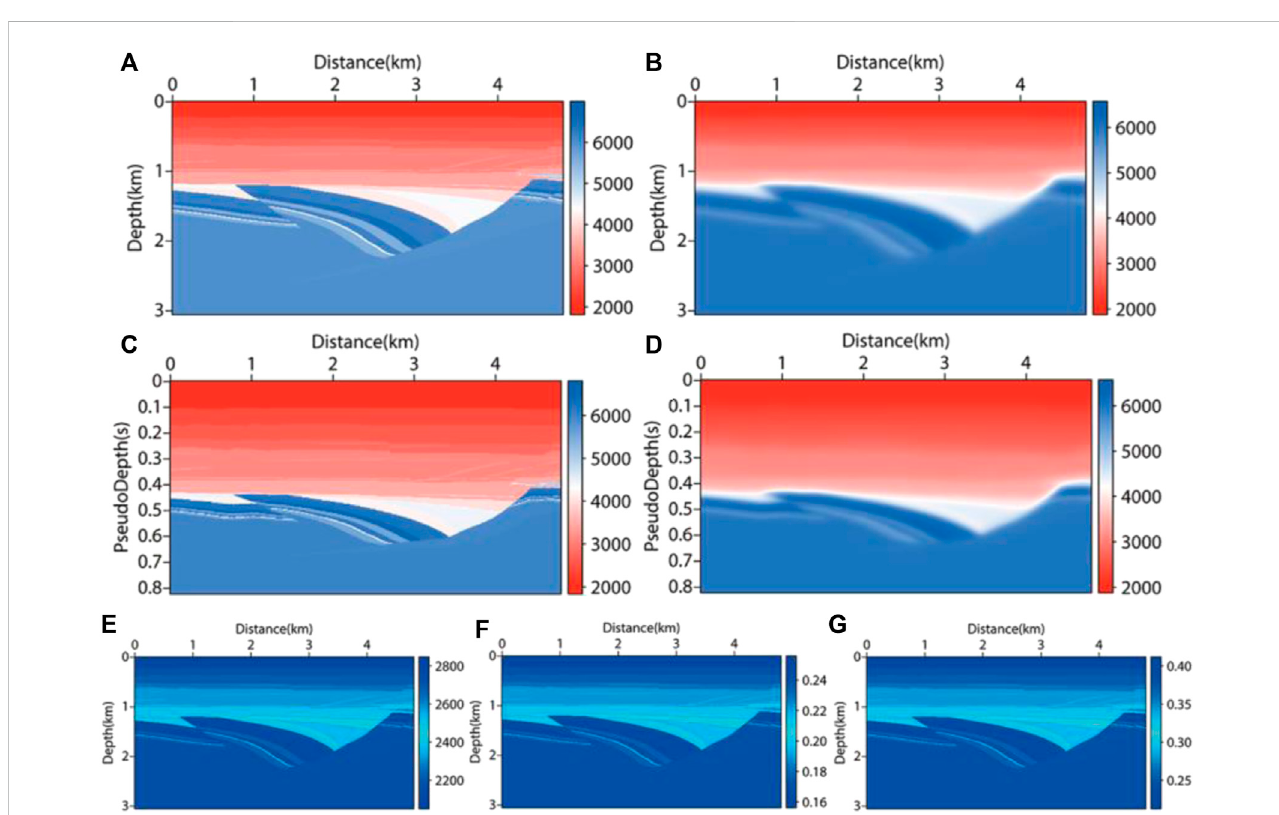
FIGURE 9 VTI parameter fi eld of SL model. (A) depth domain true velocity fi eld; (B) depth domain migration velocity fi eld; (C) pseudo-depth domain true velocity fi eld; (D) pseudo-depth domain migration velocity fi eld; (E) density ( r ) fi eld; (F) delta ( d ) fi eld; (G) epsilon ( e ) fi